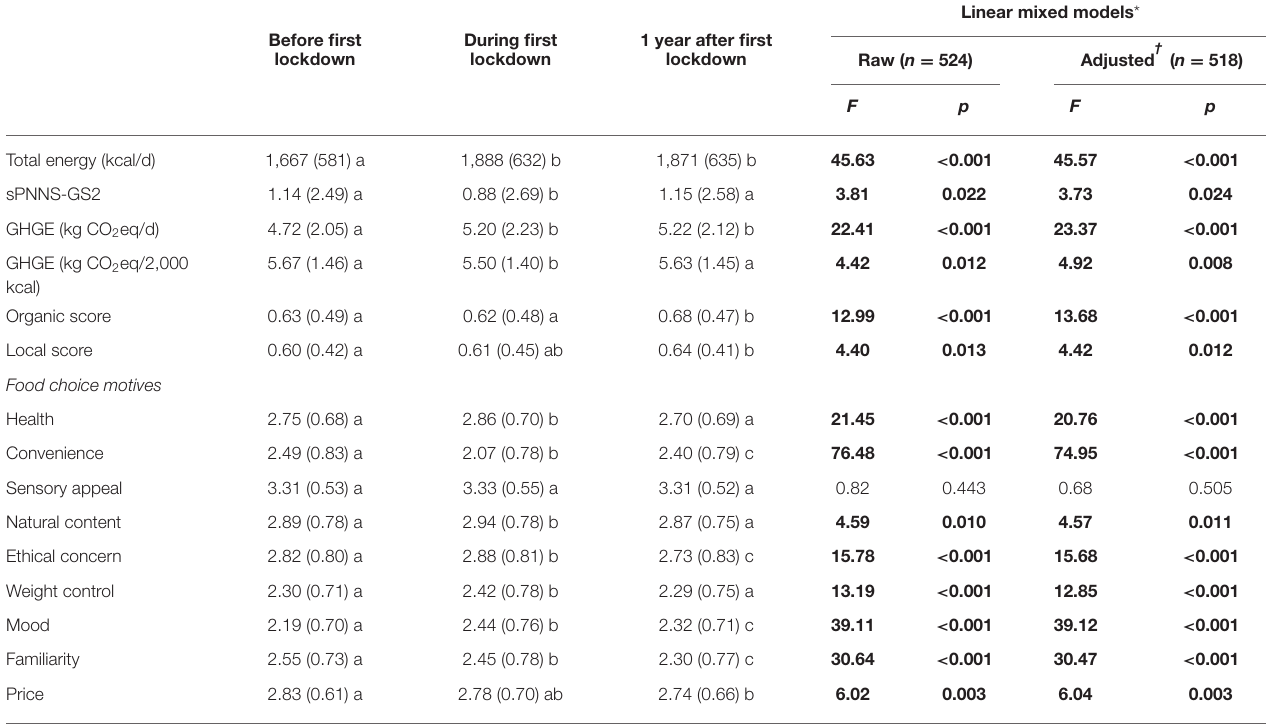
Linear mixed models